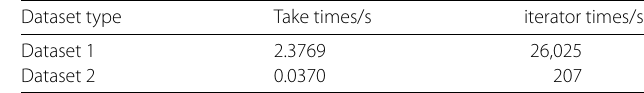
Table 5 Comparison of time and